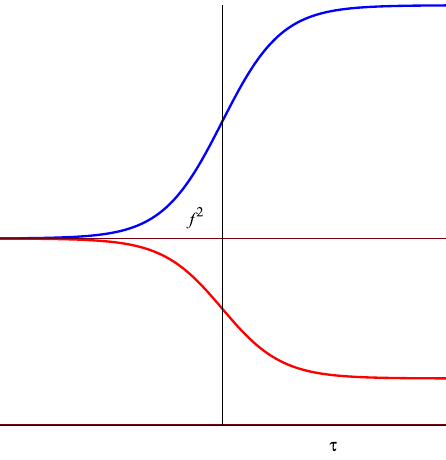
Figure 7. The function f ( (cid:28) ). The red curve has ! 0 > ! 1 and the blue curve has ! 0 < ! 1 .